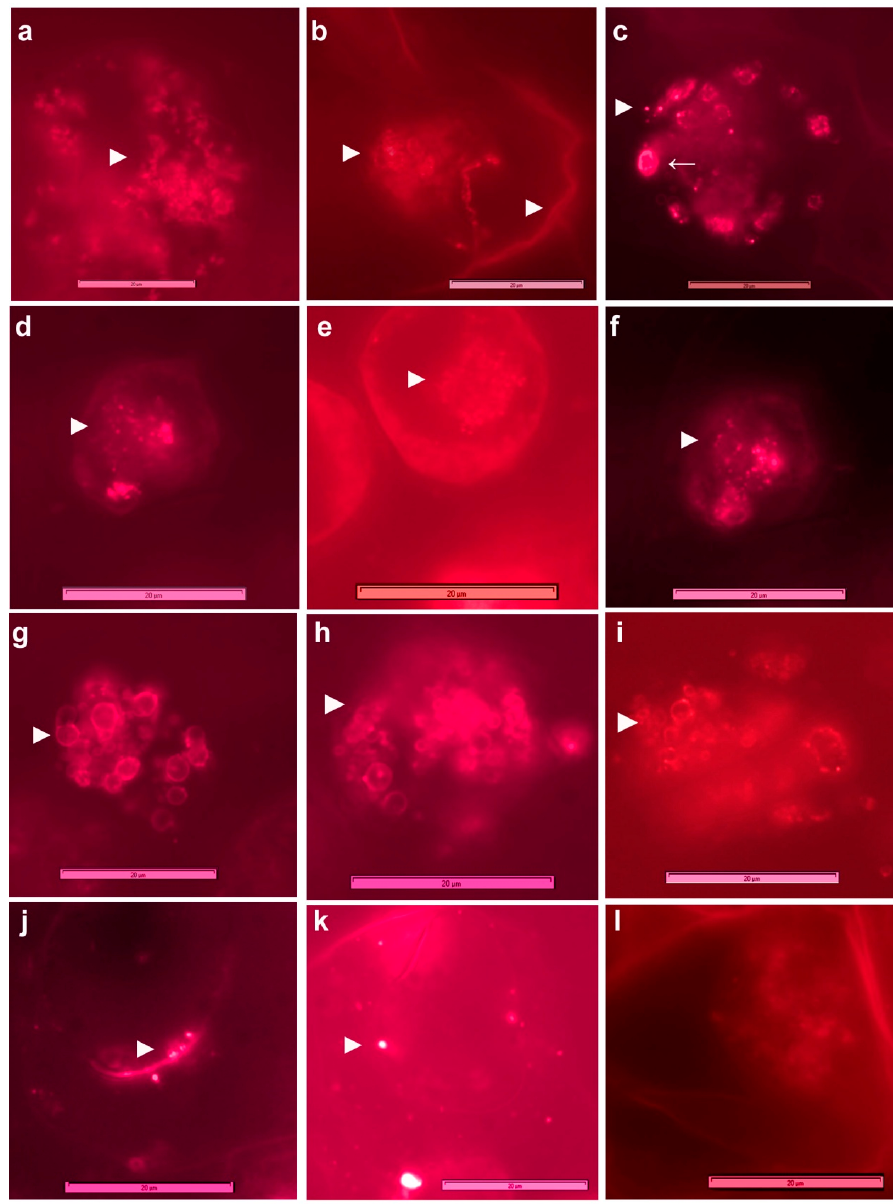
Figure 6. Fluorescent in situ hybridization (FISH) on grape suspension cells using Cy3 5 ′ -labeled 16S/23S rRNA gene probes (100× objective). ( a – c ) Actinobacteria detected with HGC69a probe in the cell matrix, along the plasma membrane and around the cell organelles; ( d – f ) α -Proteobacteria with ALF969 probe in the cell matrix; ( g – i ) γ -Proteobacteria with GAM42a probe around the cell organelles, ( j , k ) β -Proteobacteria with BET42a probe seen in the cytoplasm and along the cell boundary; ( l ) cells subjected to FISH using Cy3 negative control HCG69a/ns; bacteria indicated by ► (bar = 20 µm). Adjustments to the images in brightness or color balance have been made to improve the bacterial detection extent of which is reflected in the color shade of the scale bar.